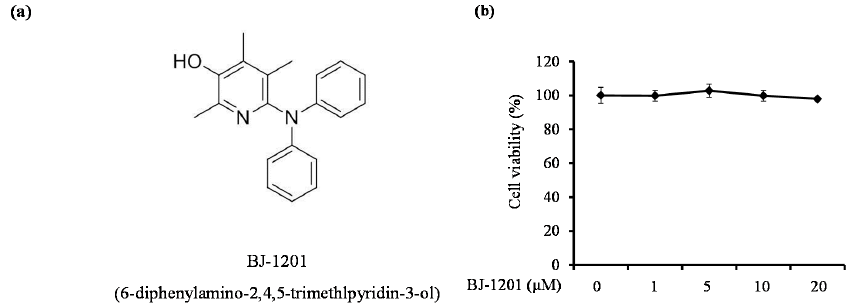
Figure 1 . Cont . Figure 1. Cont